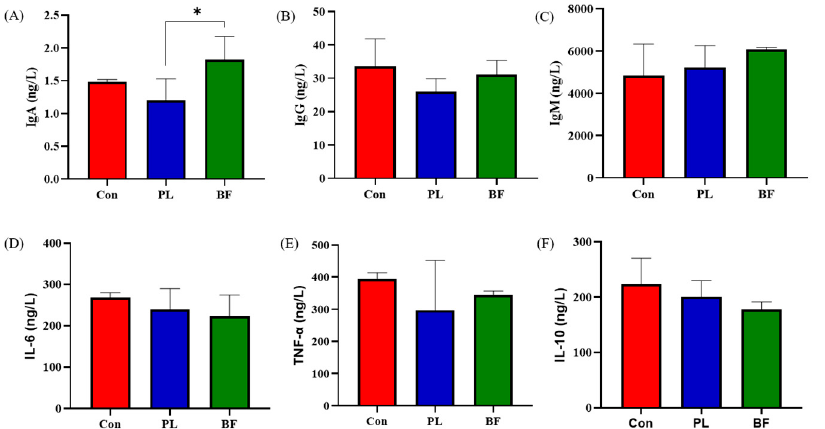
Figure 5. The concentration of ( A ) IgA, ( B ) IgG, ( C ) IgM, ( D ) IL-6, ( E ) TNF- α , and ( F ) IL-10 in the blood samples from mice at the end of the animal experiment (14th d); *: p < 0.05. All data are presented as mean ± SD. Note: Con means control group; PL means planktonic group; BF means biofilm group.